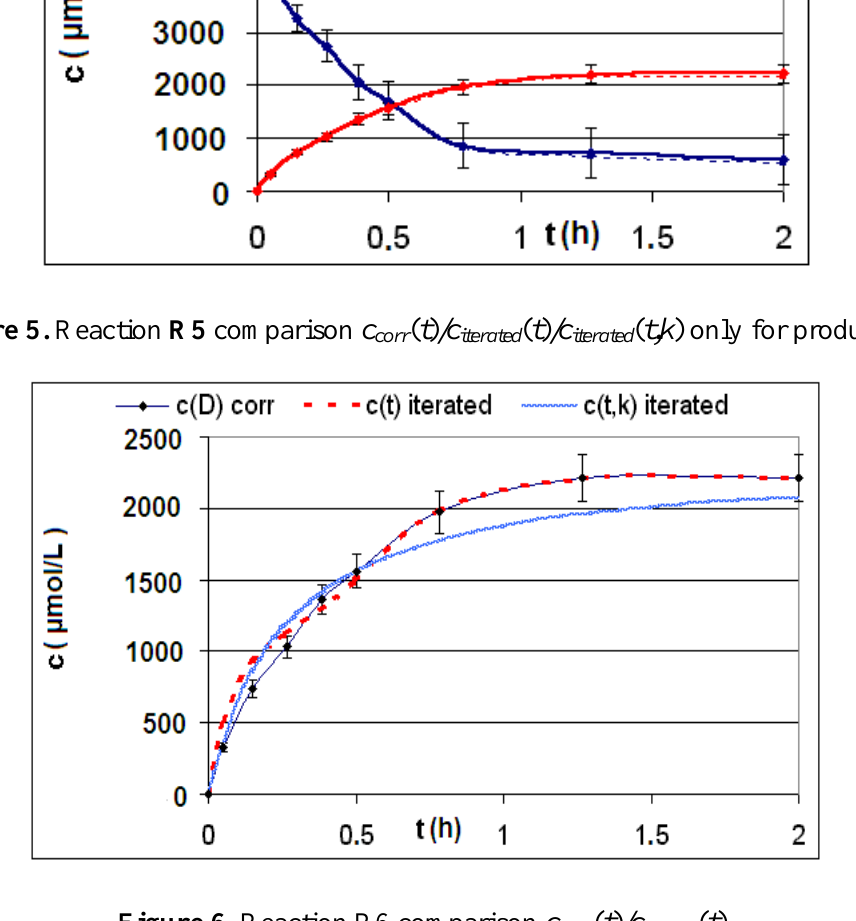
Figure 4. Reaction R5 comparison c